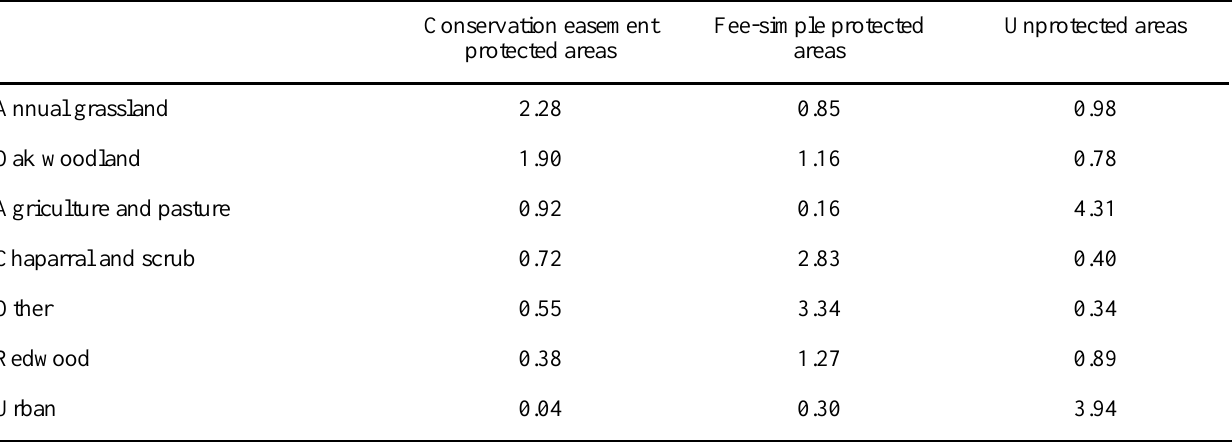
Table 3 . Odds ratios for the area in each vegetation type that occurred in conservation easement, fee-simple, or unprotected properties. Odds ratios greater than 1 indicate a positive correlation between vegetation and acquisition type, whereas odds ratios between 0 and 1 indicate a negative correlation, with values closest to 0 indicating the strongest negative